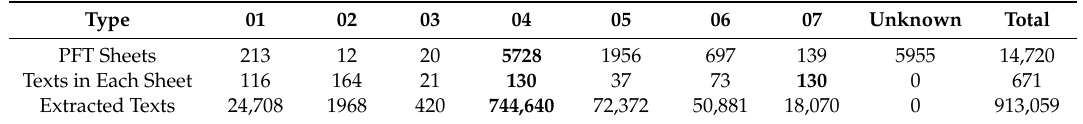
Table 1. Type classification results using